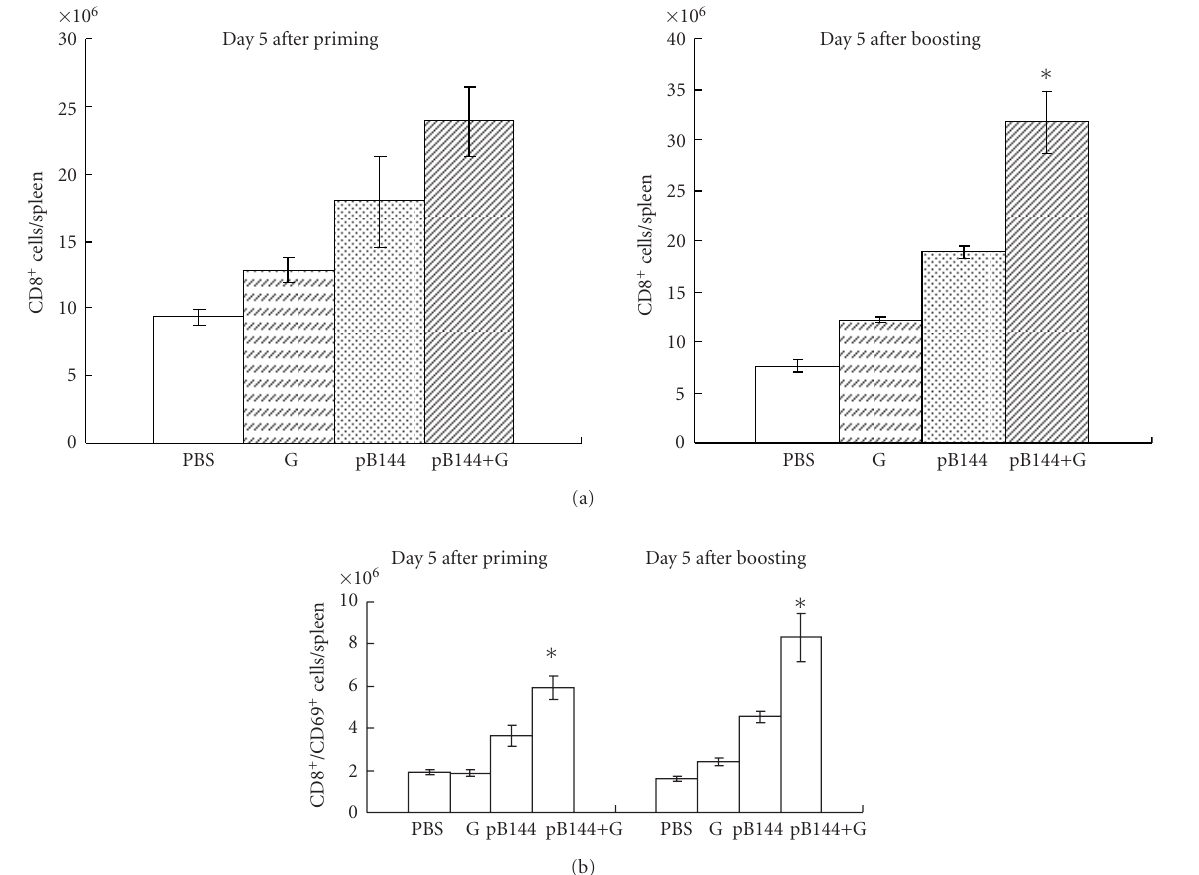
Figure 3: E ff ect of β -glu6 on pB144-induced recruitment and activation of CD8 + T cells in the spleen. Mice were immunized with β -glu6 (G), pB144, pB144+G, or PBS, as described in Section 2. Five days after priming and five days after boosting, the number of CD8 + T cells (a) and CD8 + /CD69 + T cells (b) in the spleen were evaluated. Data are expressed as mean ± SD of 3 mice/group. ∗ P < . 05, pB144+G versus pB144